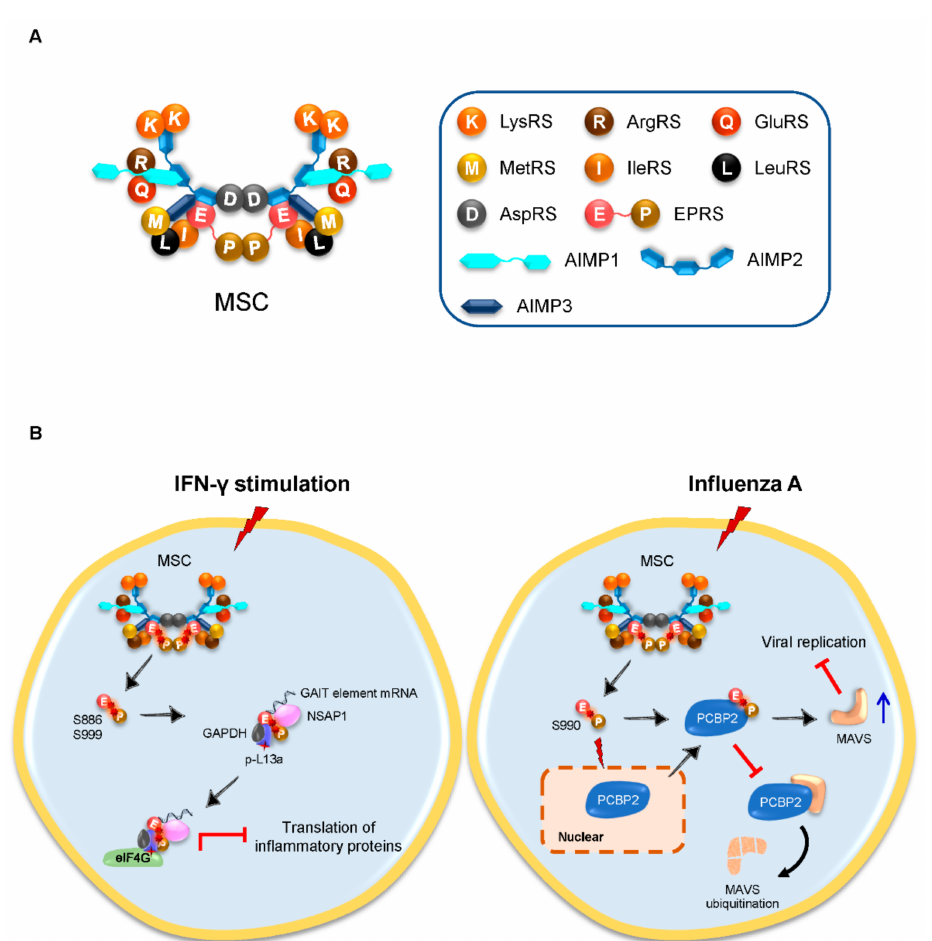
Figure 1. MSC and EPRS in viral infection. ( A ) Schematic representation of the MSC, which con- tains 9 cy-aaRSs and 3 AIMPs. The cartoon model of the MSC was generated based on previ- ous studies [11–13]. AIMP, aaRS-interacting multi-functional protein; ArgRS, arginyl-tRNA syn- thetase; AspRS, aspartyl-tRNA synthetase; EPRS (E-P), glutamyl-prolyl-tRNA synthetase; GluRS, glutamyl-tRNA synthetase; IleRS, isoleucyl-tRNA synthetase; LeuRS, leucyl-tRNA synthetase; LysRS, lysyl-tRNA synthetase; MetRS, methionyl-tRNA synthetase; and MSC, multi-synthetase complex. ( B ) IFN- γ stimulation induces sequential phosphorylation of EPRS at serine 886 (S886) and S999 (red stars), which results in the dissociation of EPRS from the MSC. The released EPRS forms a GAIT complex with NSAP1, p-L13a, and GAPDH. The GAIT complex further represses translation of inflammatory proteins via its interaction with eIF4G (left). By contrast, influenza A induces EPRS phosphorylation at S990 (red star) and causes its release from the MSC. The released EPRS inter- acts with PCBP2 and blocks PCBP2-mediated ubiquitination of MAVS. The increase in stabilized MAVS (blue arrow) further suppresses viral replication (right). eIF, eukaryotic initiation factor; GAIT, IFN- γ -activated inhibitor of translation; GAPDH, glyceraldehyde-3-phosphate dehydrogenase; IFN, interferon; MAVS, mitochondrial antiviral signaling protein; NSAP1, NS1-associated protein 1; PCBP2, poly(rC)-binding protein 2; and p-L13a, phosphorylated ribosomal protein